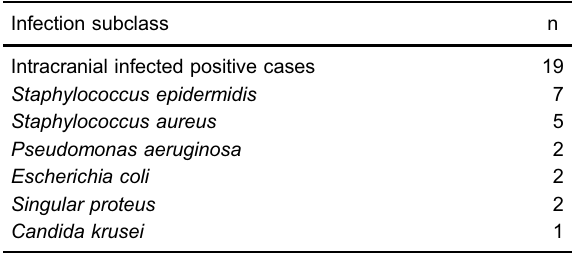
Table 2. Summary of microbial culture results of 35 intracranial- infected patients.